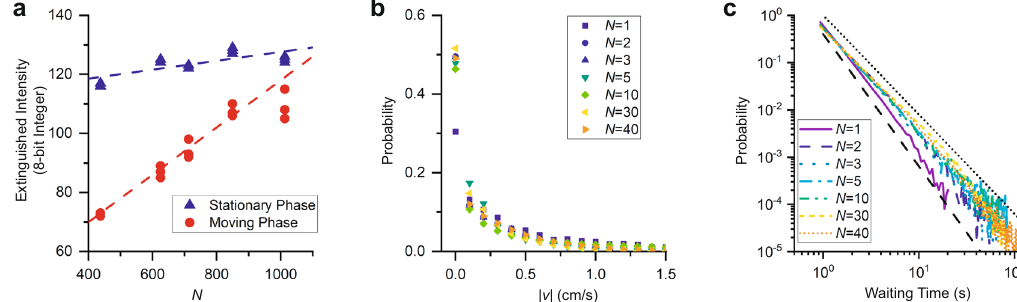
Fig. 4 | Departure from equilibrium analogy. a Measurements of the intensity of the light extinguished by the stationary clusters (blue triangles) and the actively moving phase (red circles) for various numbers of ants contained in D =4.50cm cells. The dashed lines are guides to the eye to show that both densities are increasing. b The speed distributions for various numbers of ants in D =9.00cm